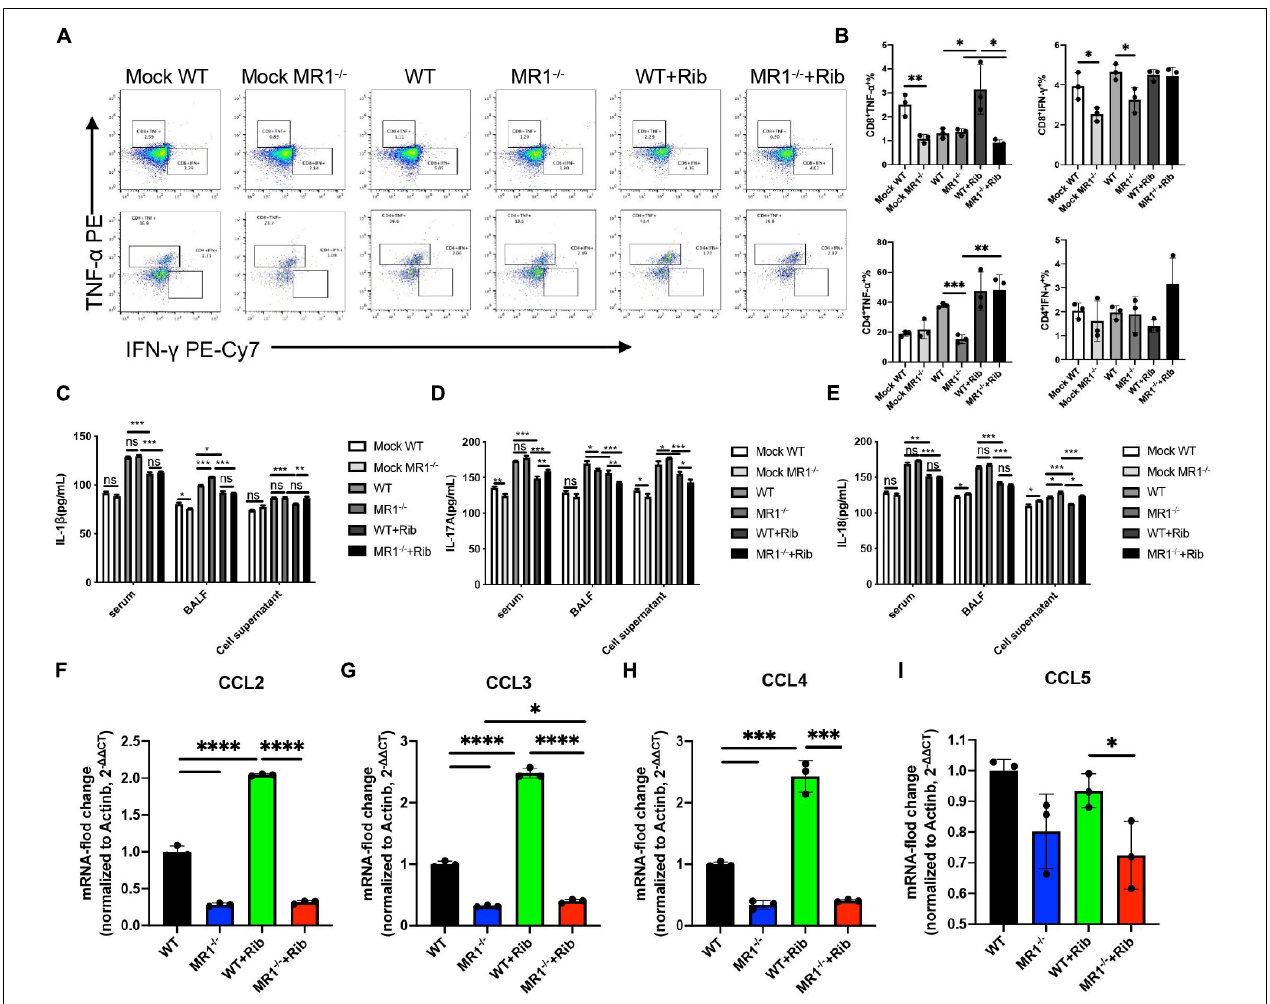
FIGURE 2 | Riboflavin pretreatment reduces the PR8-induced proinflammatory status in WT and MR1 − / − mice. Mouse lungs were collected, and cell suspensions were prepared using a total of 2 × 10 6 cells for incubation in plates containing purified PMA and NP proteins. The plates were incubated for a total of 12 h. Scatter plots of CD3 + CD4 + IFN- γ + TNF- α + and CD3 + CD8 + IFN- γ + TNF- α + (A) as percentages of IFN- γ and TNF- α cytokines in CD4 + and CD8 + T cells (B) . The serum, BALF, and cell supernatant of mice were collected, and ELISA kits were used for the analysis of IL-1 β (C) , IL-17A (D), and IL-18 (E) . The chemokines CCL2 (F) , CCL3 (G) , CCL4 (H), and CCL5 (I) in the lungs were detected by qPCR. The data are presented as the mean values ± SEMs. ∗ p < 0.05, ∗∗ p < 0.01, ∗∗∗ p < 0.001, and ∗∗∗∗ p <